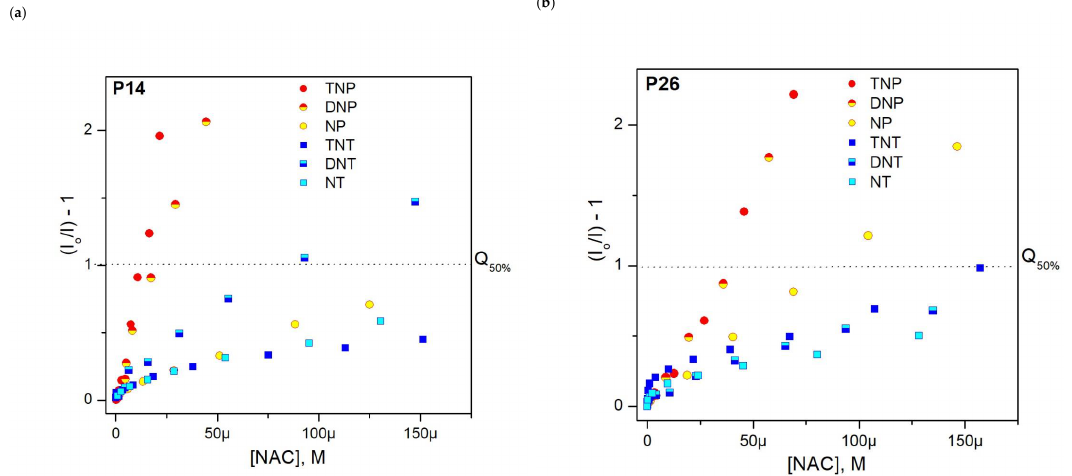
Figure 4. The Stern–Volmer plots with nitrophenols and nitrotoluenes ( a ) for P14 films ( λ exc = 384 nm, λ λ exc = 371 nm, λ obs = 470 nm) and ( b ) for P26 films ( obs = 461 nm). The graphs include a visual aid to indicate the half of the maximum quench, Q 50%